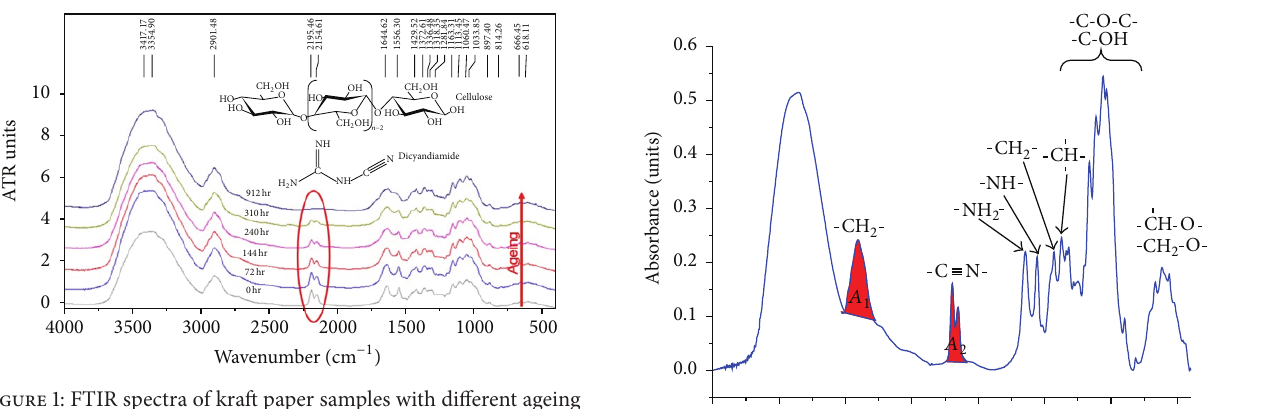
(KBr). The mixture is pressed at 6–8 tons for 15 minutes so as to obtain a transparent disc which is set for evaluation in the transmission cell of FTIR spectrometer.